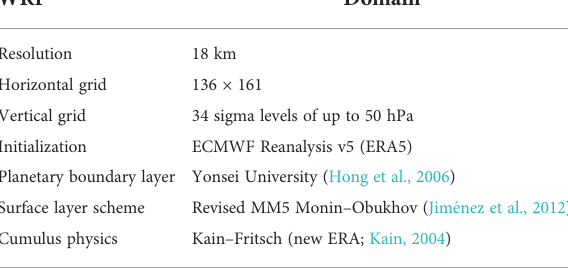
TABLE 1 Overview of weather research and forecasting (WRF) con fi gurations used in this study.